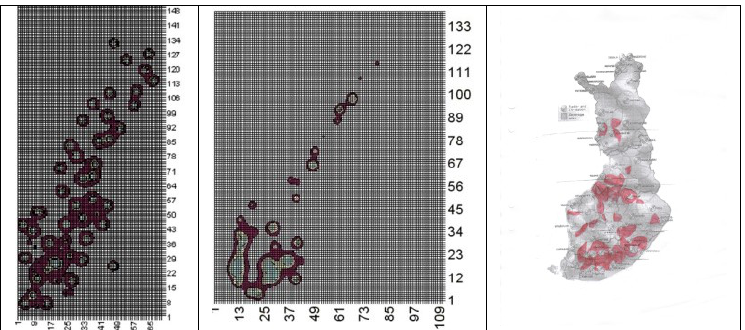
Figure 5. Calculated radiation levels from main broadcasting transmitters in Sweden, Norway and Finland. The first graph represents Sweden and shows areas with highest radiation levels. The second plot represents Norway, showing the highest levels in the south part of the country. The third plot gives areas in Finland covered by three or more main broadcasting transmitters (red